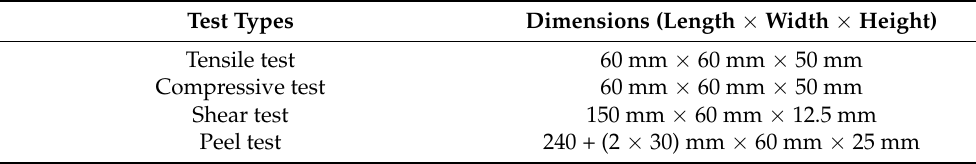
Table 2. The dimensions of the test specimens.